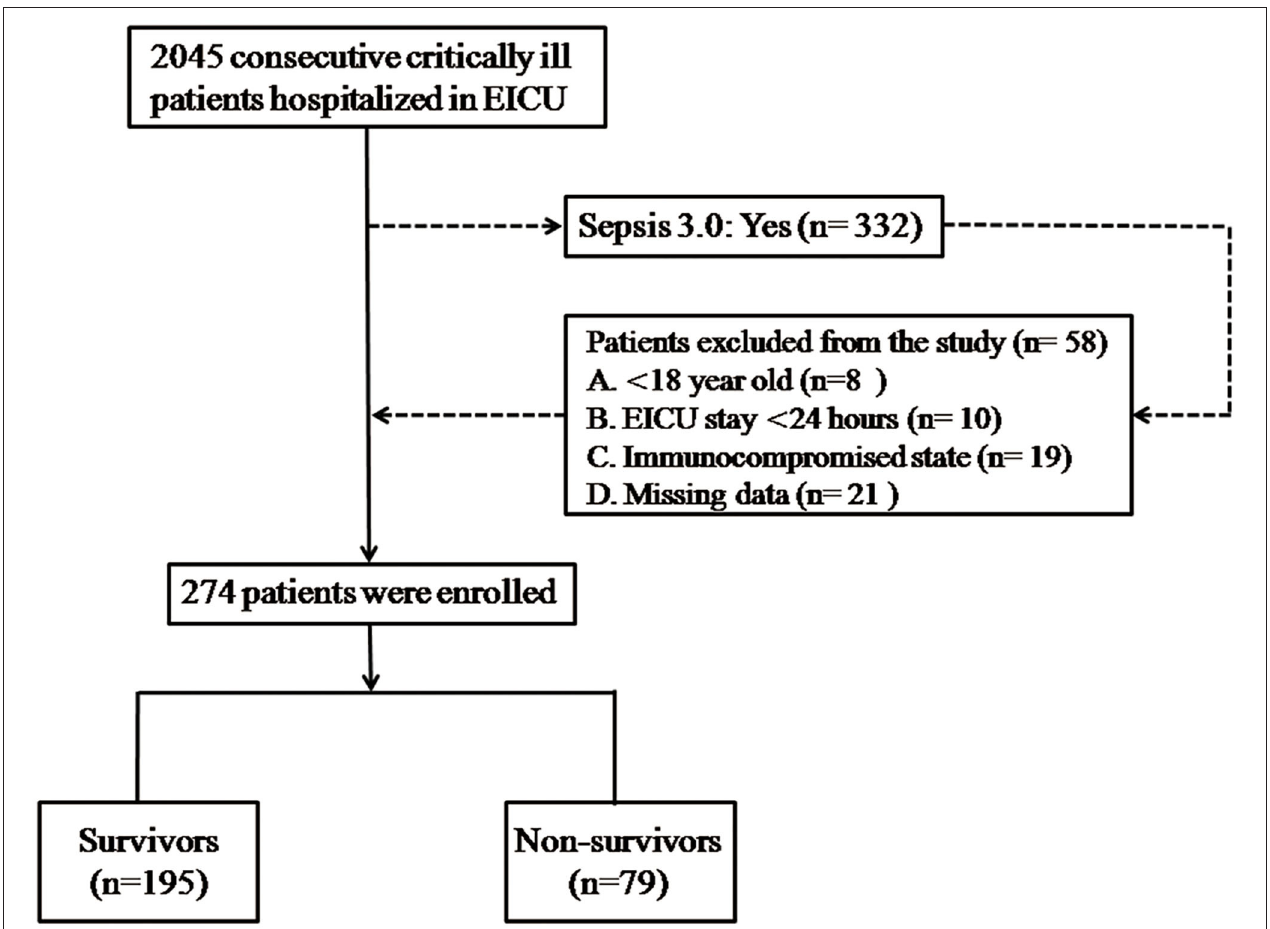
FIGURE 1 | Flowchart of the enrolled patients. There were 2,045 adult patients who met the diagnostic criteria of the Surviving Sepsis Guideline (Sepsis 3.0), who were tested in this study, and 264 enrolled patients were stratified into the survivor and non-survivor groups. Demographic data and clinical and laboratory parameters were compared between the survivor and non-survivor